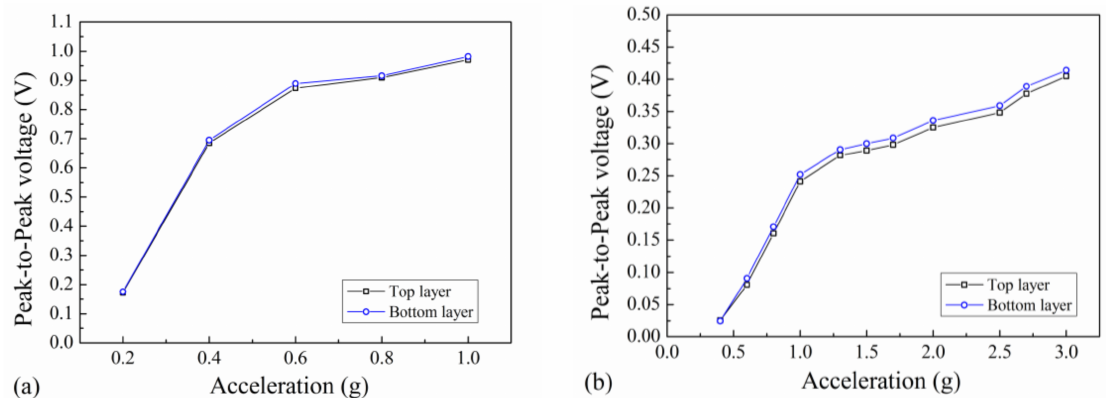
Figure 10. The open-circuit output voltage of the EVEH as a function of acceleration level on ( a ) Z-direction and ( b )